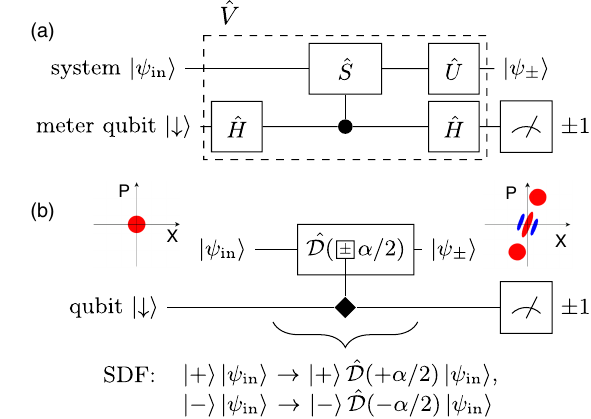
FIG. 1. (a) Circuit model of the measurement type used in this paper. In general, a measurement proceeds by coupling the ˆ V system of interest to a meter via a unitary transformation (enclosed in the dashed box). Our measurements use a qubit as the meter system, and a common coupling is given by a ˆ S controlled-unitary ( ). This gives a phase kickback on the meter ˆ S qubit depending on the eigenvalue of the operator . The phase change is converted to a qubit population by applying the ˆ H controlled operation between two Hadamard gates ( ). The ˆ V ˆ U action of may involve additional unitary transformations , which affect the post-measurement state but not the measurement outcome. (b) In our experiments, the system of interest is a harmonic oscillator. The core element is a spin-state-dependent force (SDF), which realizes a phase-space displacement ˆ D ð(cid:3) α = 2 Þ , with the displacement sign dependent on the ˆ σ x eigenstate of the qubit. This is denoted with the diamond control. This realizes a circuit of the type shown in diagram (a) with ˆ D ˆ D ˆ S ˆ U ¼ − ð α Þ and ¼ ð − α = 2 Þ . Shown as input is the Wigner function of the oscillator ground state, which is projected into a “ Schrödinger ’ s cat ” like superposition by the measurement with ffiffiffiffiffiffiffiffiffiffiffiffiffi p P ð(cid:3) 1 Þ the relative phase of the two components correlated with the . measurement